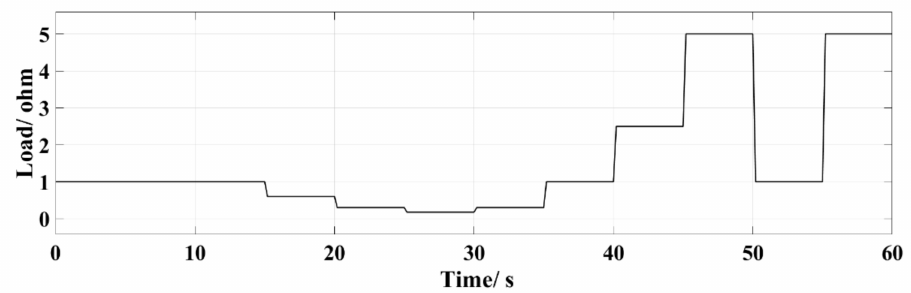
Figure 5. Load variation